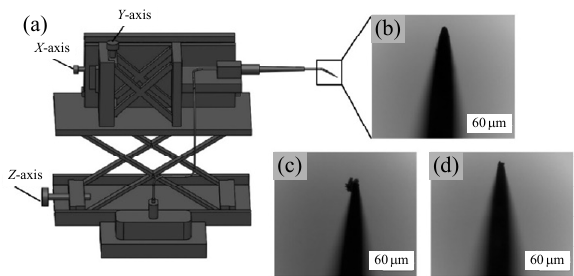
Fig. 4 3D moving heating micromanipulator diagram: (a) micromanipulator device moving in X , Y , and Z 3D space, (b) magnified view of tungsten steel tip, (c) tungsten steel probe tip and fluorescent powder sticking attached together due to the presence of adhesion force, and (d) the reduced adhesion of the tip and the fluorescent powder when heated to 400 ℃